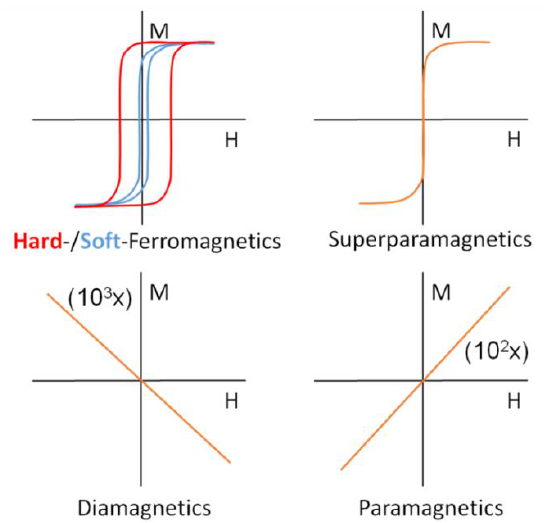
Figure 2. Magnetization (hysteresis) curves associated with the different classes of magnetic materials (i.e., Hard/Soft-ferromagnetics, superparamagnetics, diamagnetics, and paramagnetics).